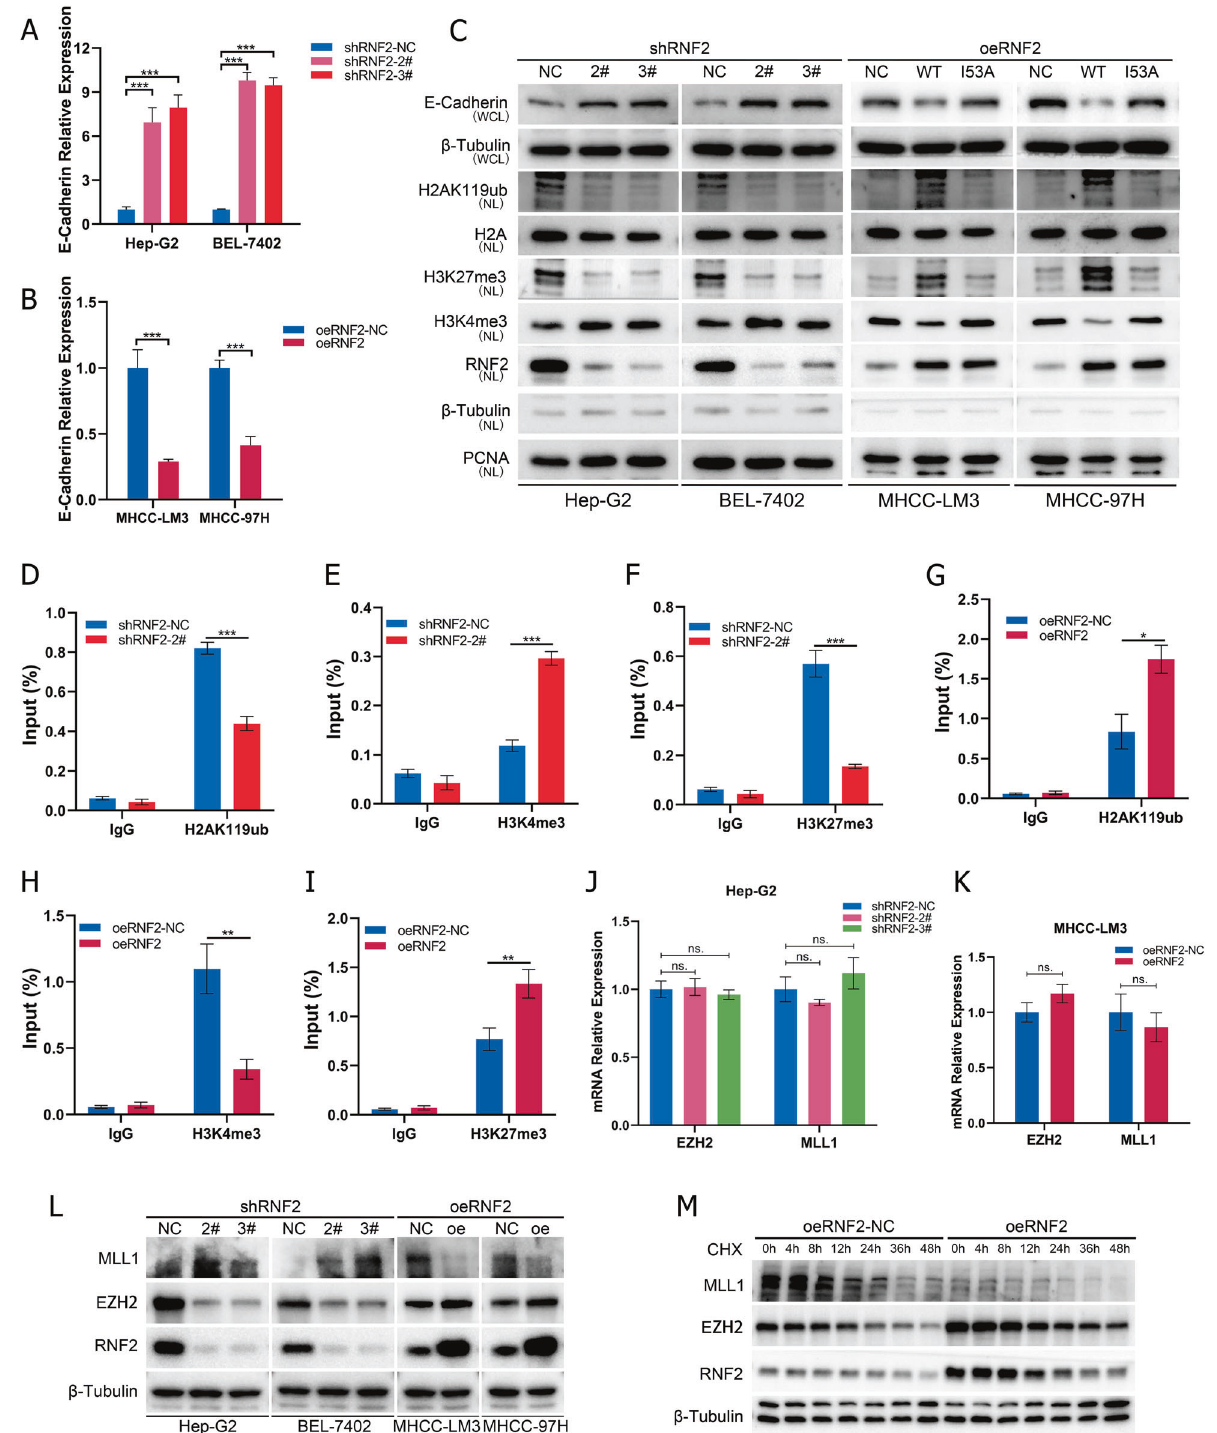
Fig. 4 RNF2 promotes histone H2A ubiquitination to inhibit E-cadherin transcription. A , B Quantitative RT-qPCR results of altered E-Cadherin expression after knockdown or overexpression of RNF2 in HCC cell lines. C Western blot visualization of altered expression of H2K119ub, H3K27me3, H3K4me3 after knockdown/overexpression of RNF2 in HCC cell lines. WCL, whole-cell lysate; NL, nuclear lysate. D – F ChIP assay was performed on Hep-G2 cells transfected with shRNF2-NC/shRNF2-2# using anti-H2AK119ub, anti-H3K4me3 and